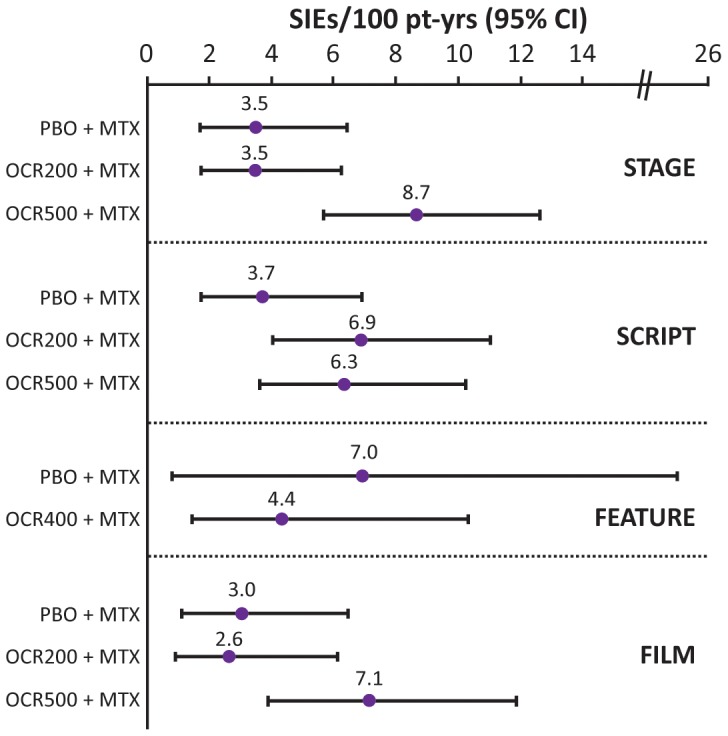
Rates of serious infectious events (SIEs) in the double-blind, placebo-controlled periods.Multiple occurrences of the same event in one individual were counted multiple times. MTX, methotrexate; OCR200, ocrelizumab 200 mg×2; OCR500, ocrelizumab 500 mg×2; PBO, placebo; pt-yrs, patient-years.